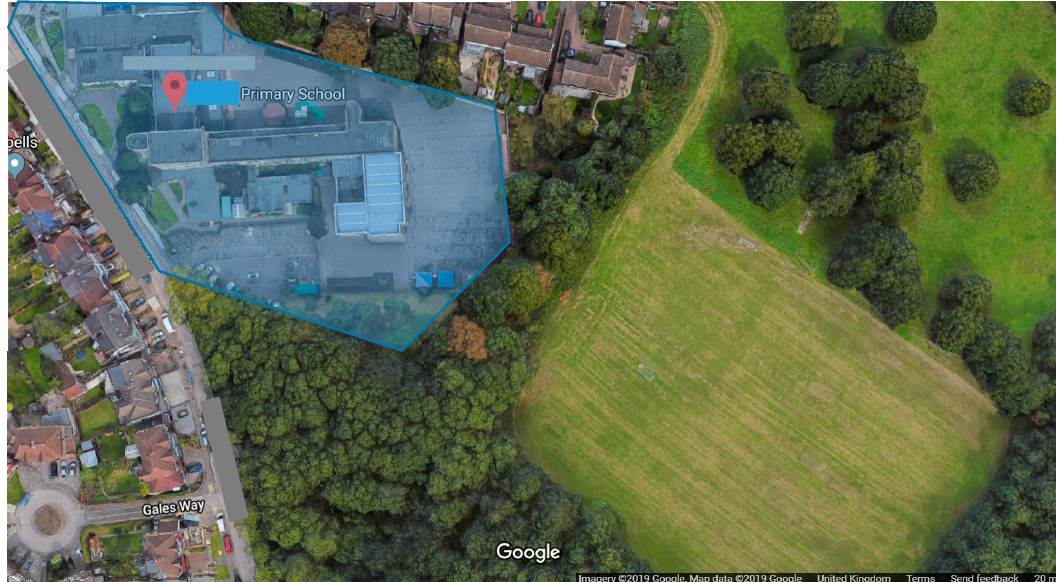
Figure 1. Google earth image of the school showing the school premises and the surrounding area.